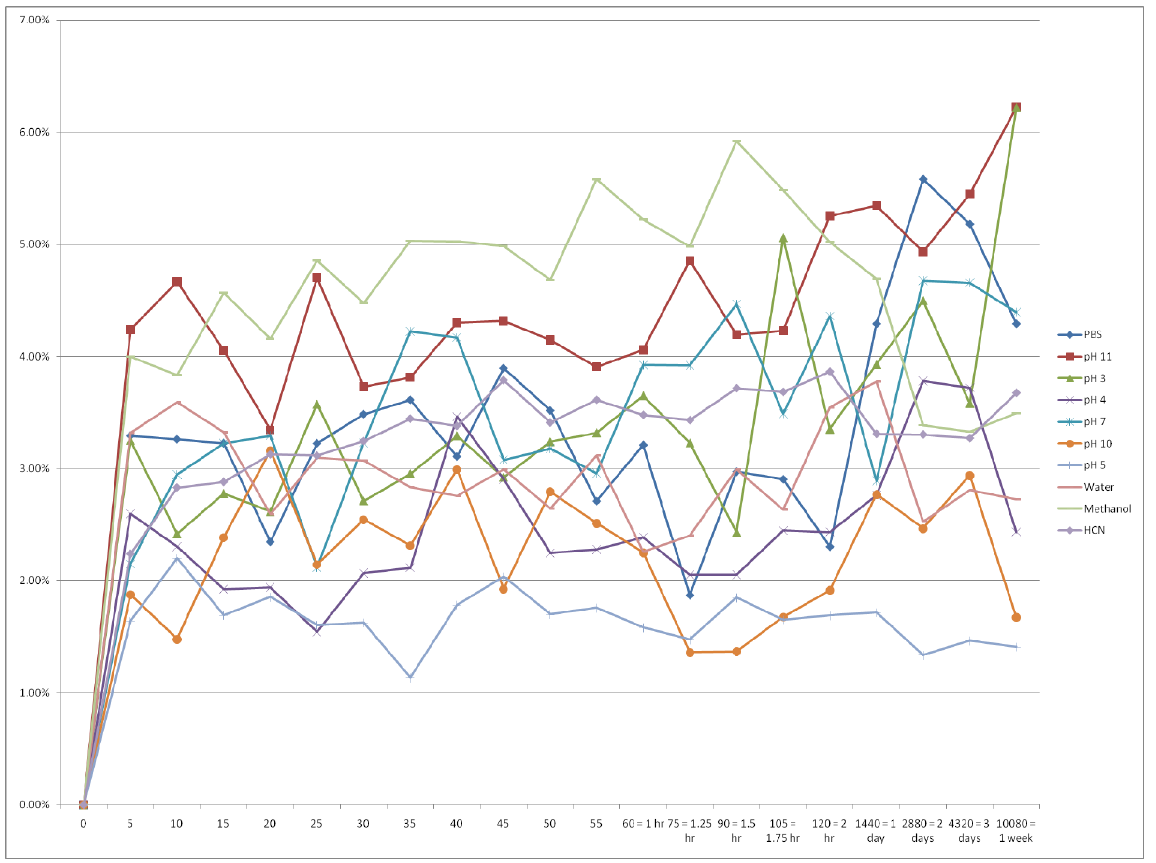
Figure 6. Organic solvents which cause less than 10% of swelling in PDMS for duration of one week.